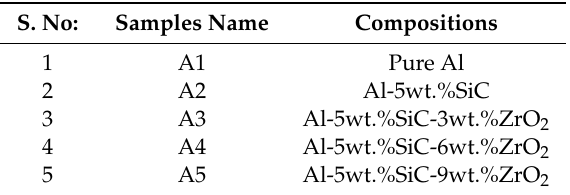
Table 1. The composition ratio of the Al-SiC-ZrO 2 nanocomposites. S. No: